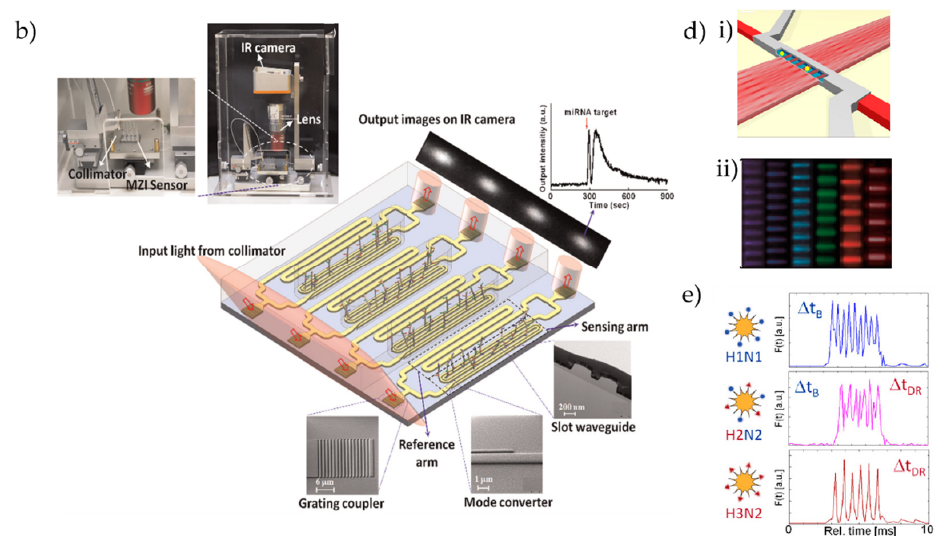
Figure 5. ( a ) Integrated Dengue virus biosensor comprising an in-line microfluidic blood plasma separator and a cavity-coupled nanoimprinted plasmonic array. Inset corresponds to the nanoimprinted plasmonic biosensor composed of a gold mirror (80 nm), a dielectric film spacer ( ∼ 700 nm) embossed with a square array of holes, a conformal thin film of aluminum oxide layer (20 nm) as the fluid barrier, and a thin gold film (30 nm) [268]. ( b ) Schematic diagram of the MZI biosensor system for miRNA detection [269]. ( c ) Principle of fluorescence-based particle detection in ARROW optofluidic devices. Inset: an actual APD trace of particle detection (Figure 5c is used upon permission from the Applied Optics group at the University of California, Santa Cruz, CA, USA]. ( d ) ( i ) Schematic view of MMI waveguide intersecting with a fluidic microchannel containing target particles [276]. ( ii ) Photographs of multispot excitation patterns created in fluidic channel filled with fluorescent liquid. The entire visible spectrum is covered by independent channels (405 nm/11 spots, 453/10, 488/9, 553/8, 633/7, 745/6). (The original black and white color scale was rendered in the actual excitation colors) [276]. ( e ) Schematic view of the labeling scheme for the three influenza types and their resulting single-virus fluorescence signals; the H2N2 virus shows a mixture of six and nine peaks upon blue and dark red excitation [276].